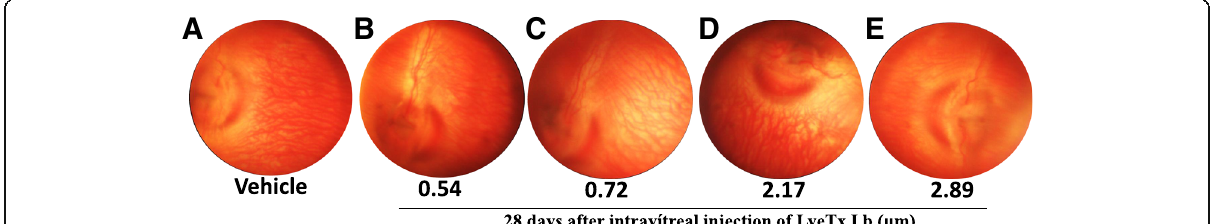
Fig. 8 Intravitreal LyeTx I b does not damage retinal vasculature: Clinical exam is shown through Clear View images indicating no damage to retinal vasculature 28 days after intravitreal injection of ( a ) Vehicle, ( b ) LyeTx I b 0.54 μ M, ( c ) LyeTx I b 0.72 μ M, ( d ) LyeTx I b 2.17 μ M and ( e ) LyeTx I b 2.89 μ